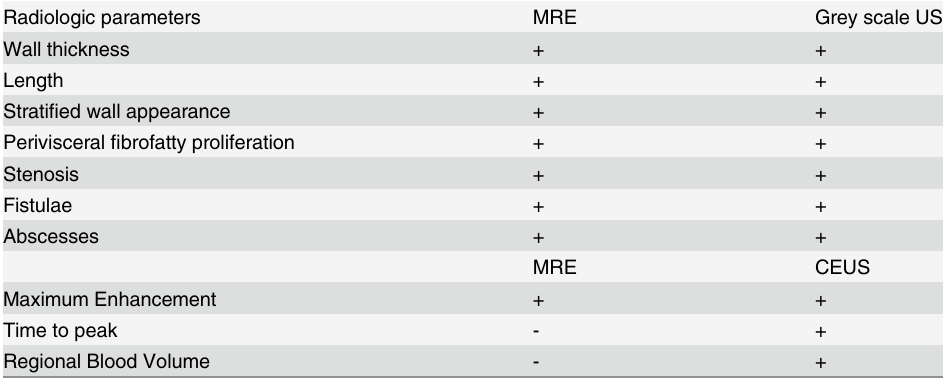
Table 1. Radiological parameters assessed by MR Eenterography (MRE), Grey scale Ultrasound (US) and Contrast enhanced Ultrasound (CEUS). Radiologic